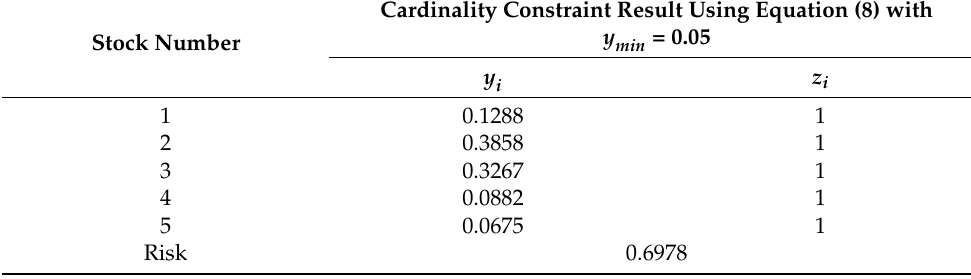
Table 2. SOA MINLP for solving the portfolio optimization problem with cardinality constraint K = 5 using data from Bartholomew-Biggs and Kane (2009). Cardinality Constraint Result Using Equation (8) with y = Stock Number min